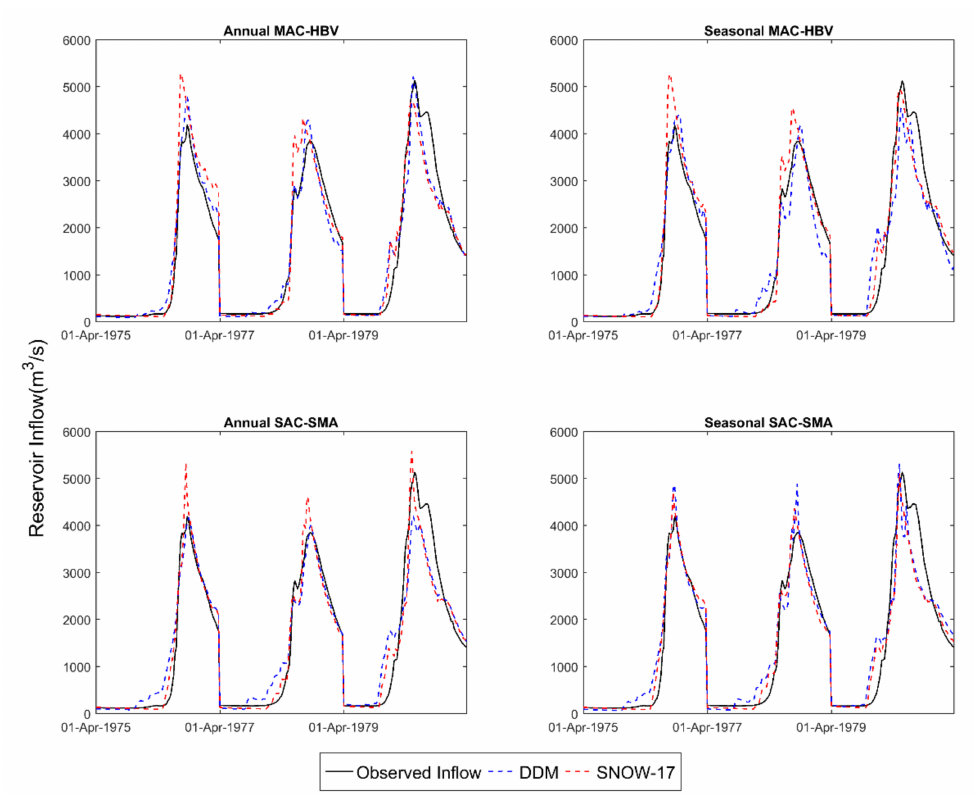
Figure 10. Validation hydrographs for spring season inflow simulations for